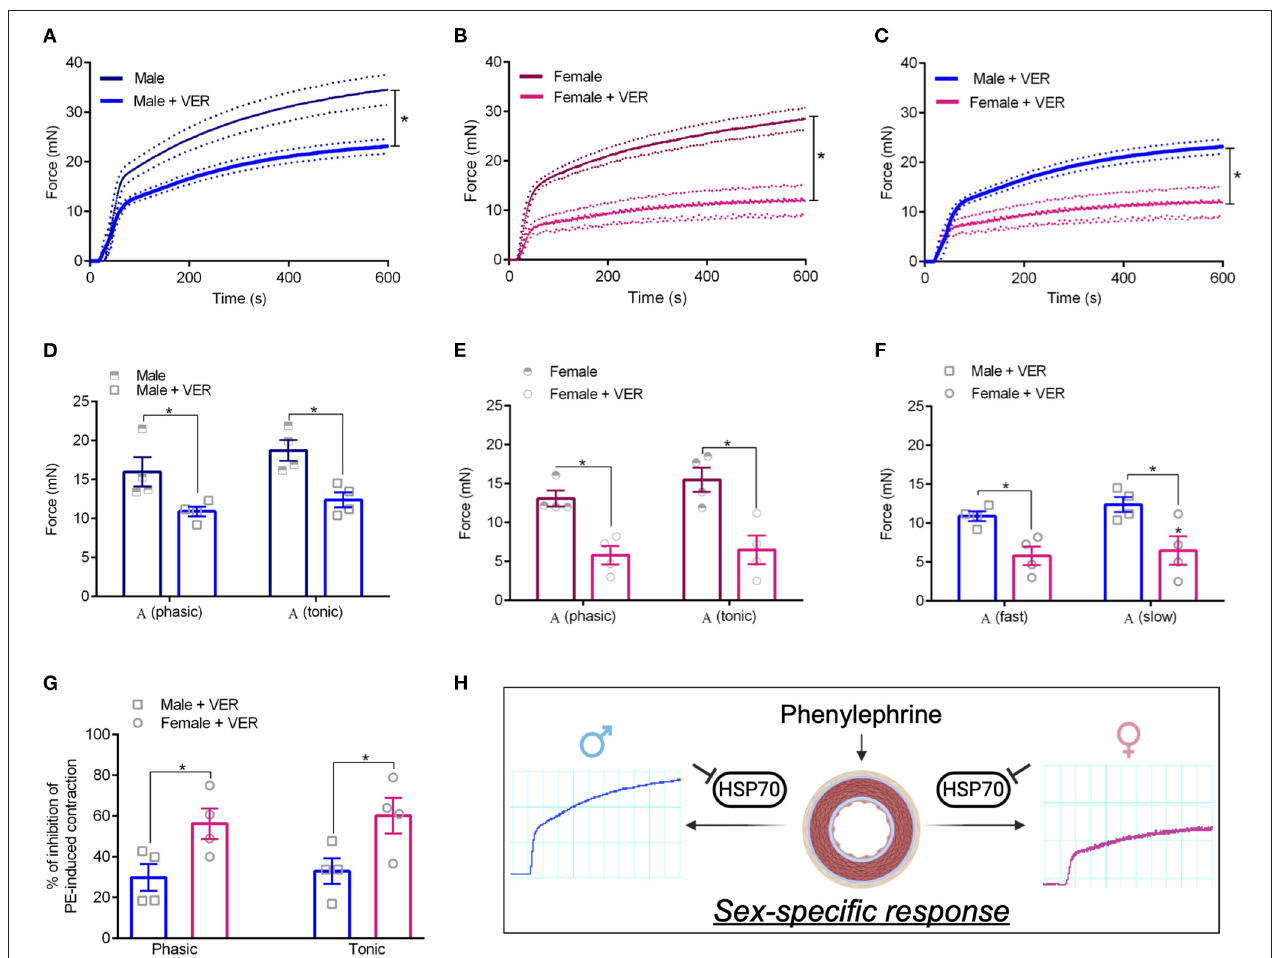
FIGURE 2 | Blockade of HSP70 significantly impairs phasic and tonic vascular contraction in female compared with male rats. (A–C) Display time vs. force curves for aortic samples incubated with vehicle (CTL) or VER1550008 (10 − 5 mol/L) for 30 min and stimulated with phenylephrine (10 − 5 mol/L) for 15 min. * p ≤ 0.05 using one-way ANOVA followed by the Bonferroni correction. Phasic and tonic E max in male (D) , female (E) , and male vs. female (F) . % of inhibition of phenylephrine-induced contraction in male vs. female (G) . * p ≤ 0.05 using two-tailed Student’s t -test. Schematic representation with inset original trace recording graphs showing the vascular response to phenylephrine following inhibition of HSP70 in male and female Sprague Dawley rats (H) . (H) Was created with Biorender.com. Data points were sampled every second for 600 s and are expressed as mean ± SEM, where the continuous line represents the mean and the traced lines depict the SEM. n =